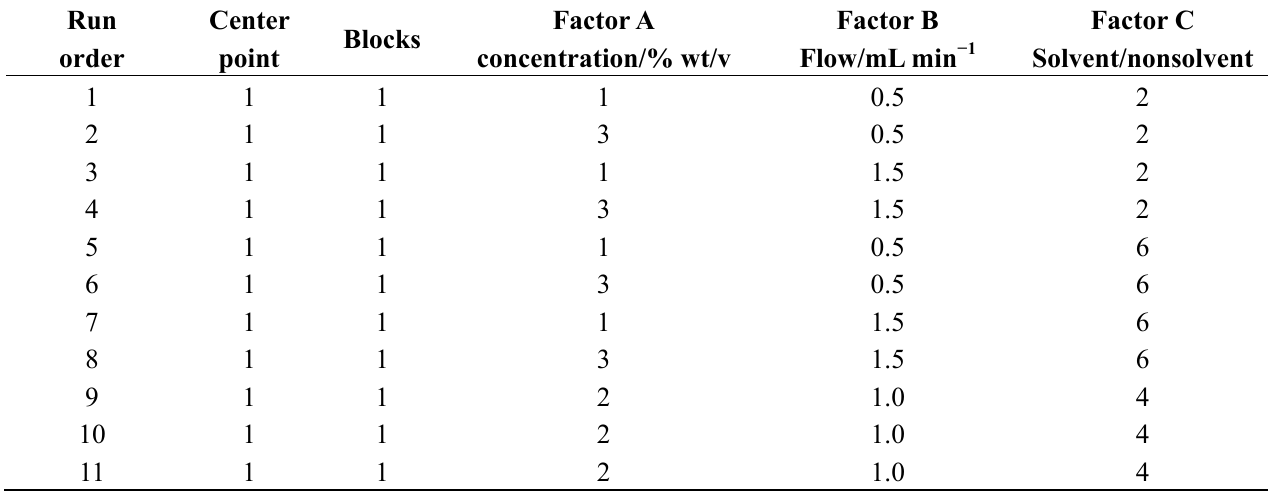
Table 2. Experiment of the factorial